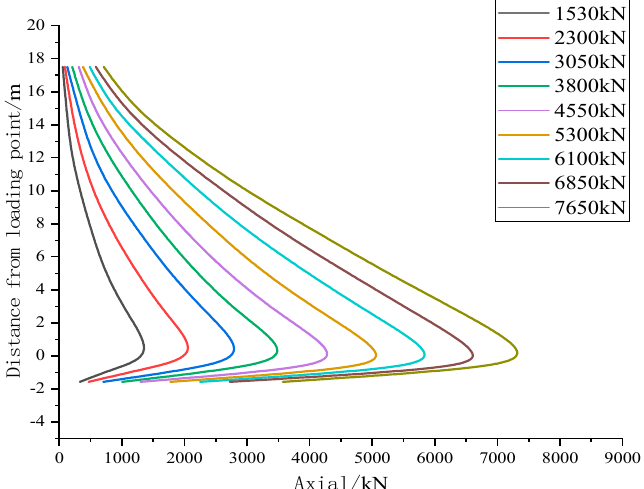
Figure 15. Axial force distribution under different